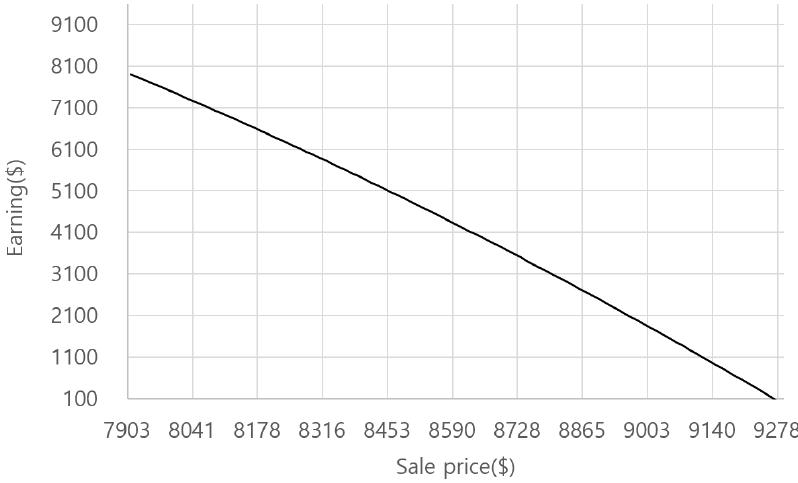
Figure 14. Pre-sale income of apartments according to each sale price.